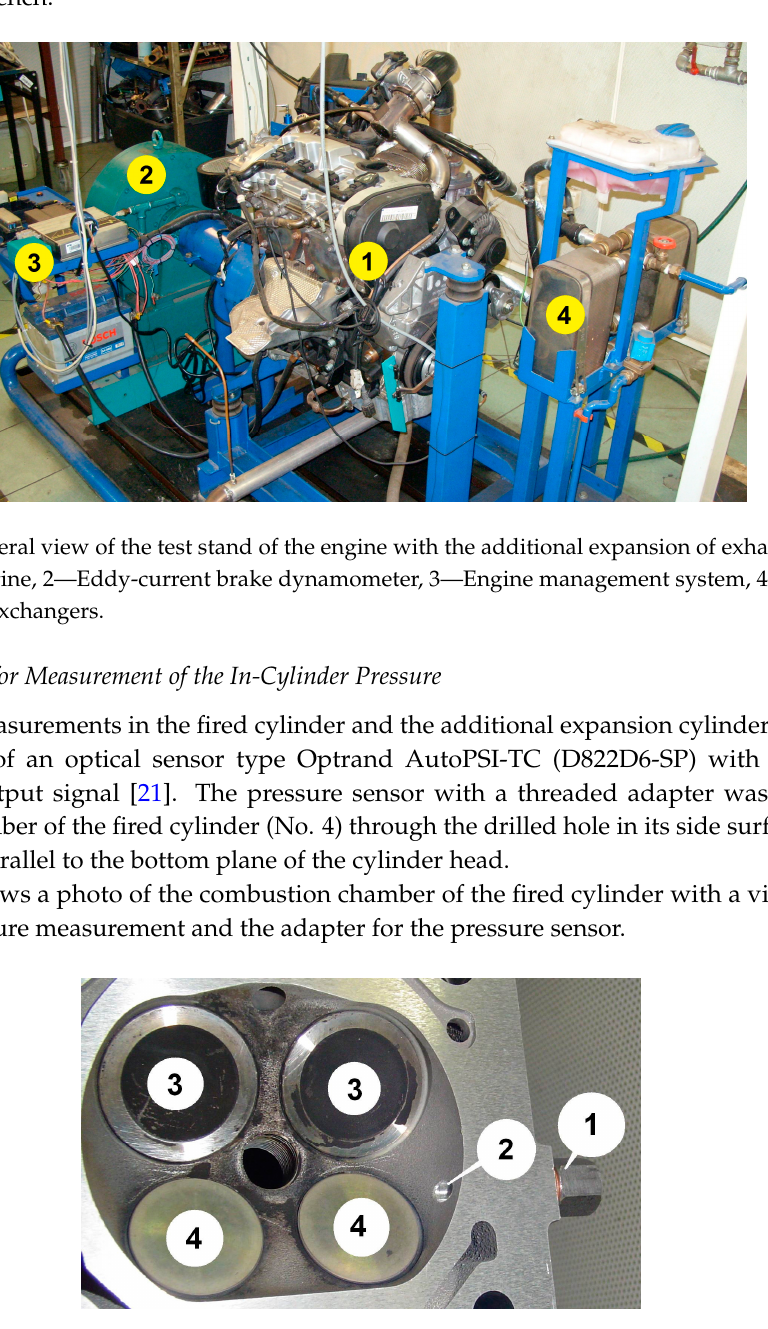
Figure 6. Combustion chamber of the fired cylinder (No. 4); 1—Adapter of the combustion pressure sensor, 2—Hole in the combustion chamber wall, 3—Intake Valves, 4—Exhaust